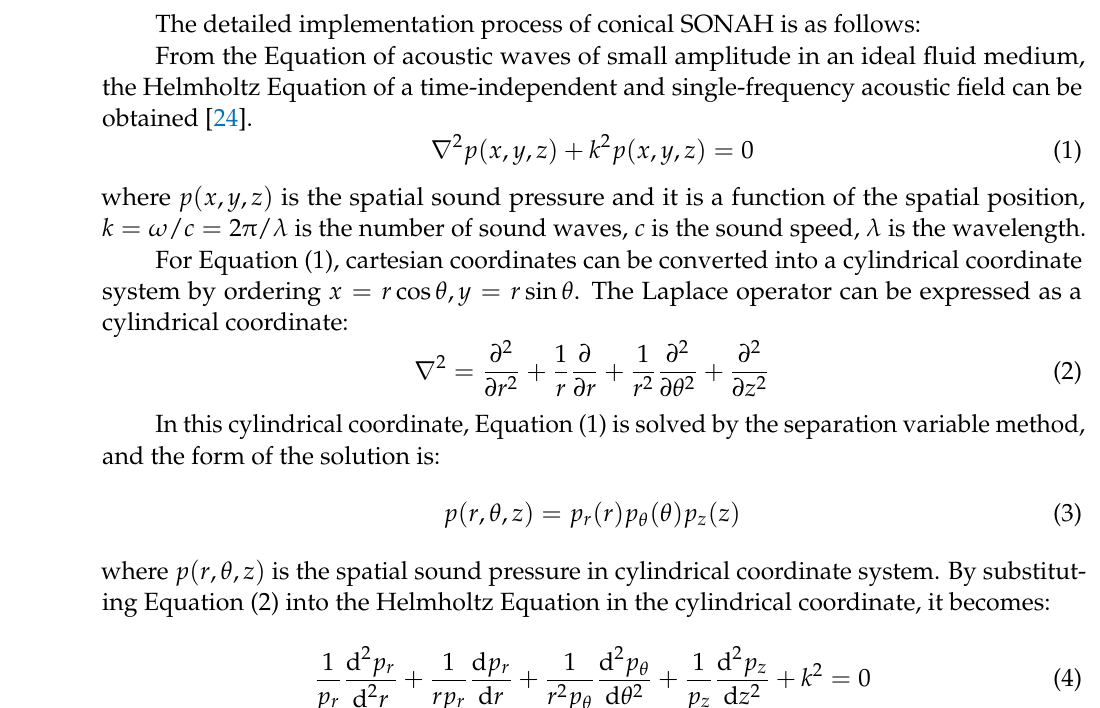
Figure 1. Implementation process of conical